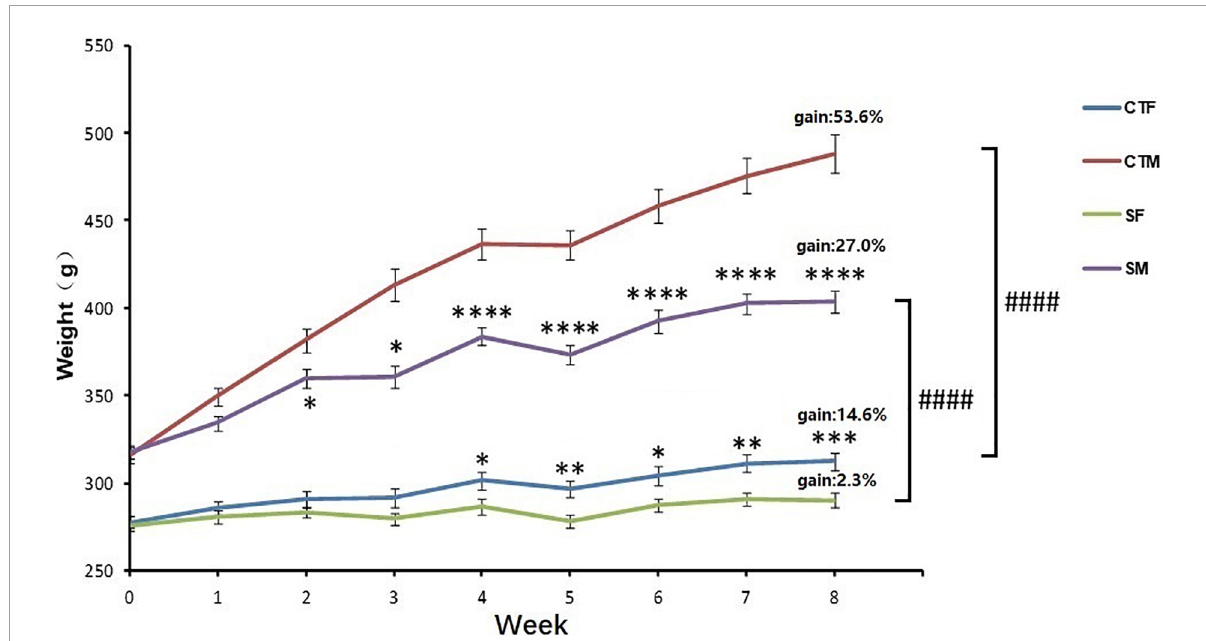
FIGURE2 CUMS reduced body weight gain in female and male rats. ∗ p < 0.05, ∗∗ p < 0.01, ∗∗∗ p < 0.001, and ∗∗∗∗ p < 0.0001, vs. control with same sex, #### p < 0.0001 vs. SM. CTF: female control, CTM: male control, SF: female stress group, SM: male stress